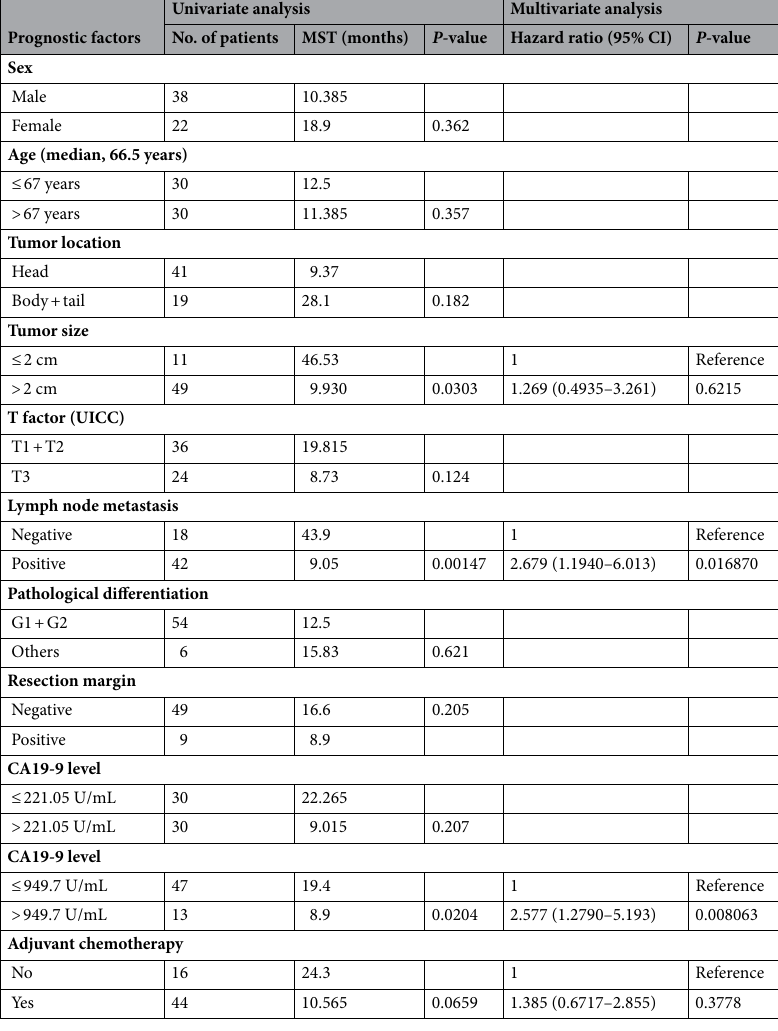
Table 3. Univariate and multivariate analyses of recurrence-free survival in the surgery group. MST, median survival time; CI, confidence interval; UICC, Union for International Cancer Control; CA19-9, carbohydrate antigen